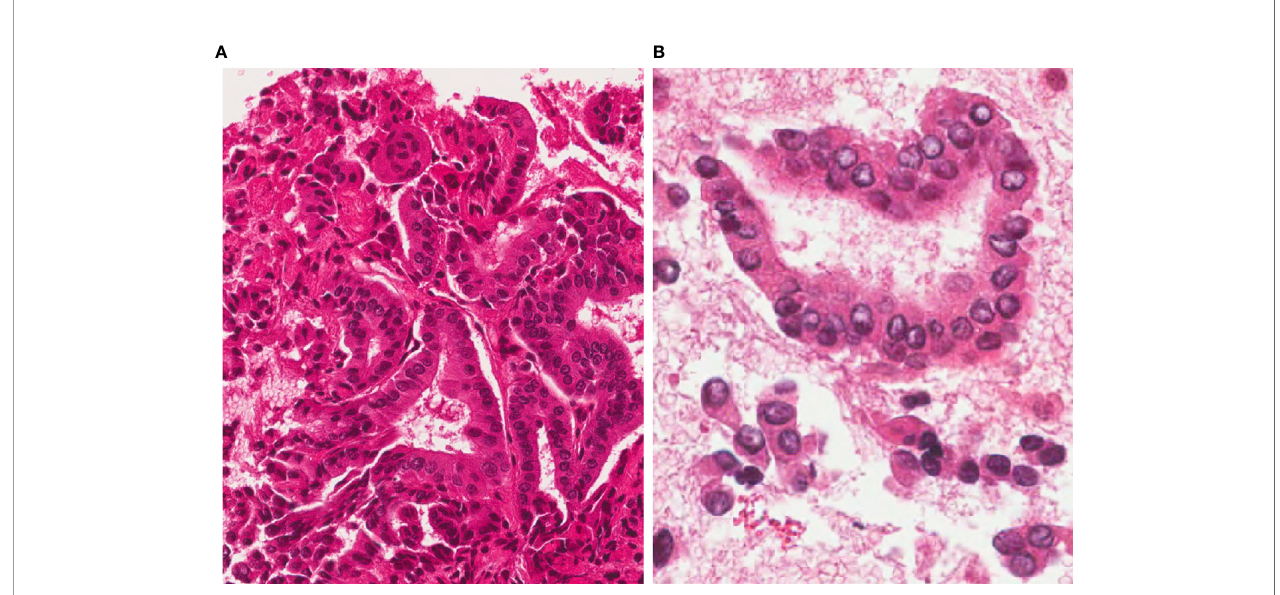
FIGURE 1 | FNAC before RFA. 4 µm-thick H&E stained sections from the cell-block show a highly cellular sample, with a typical papillary architecture; thyrocytes show irregular, large and clear nuclei. A diagnosis of Papillary Thyroid Carcinoma (TIR5 according to the Italian SIAPEC-IAP classi fi cation of thyroid cytology) was formulated ( A , magni fi cation x200; B ,